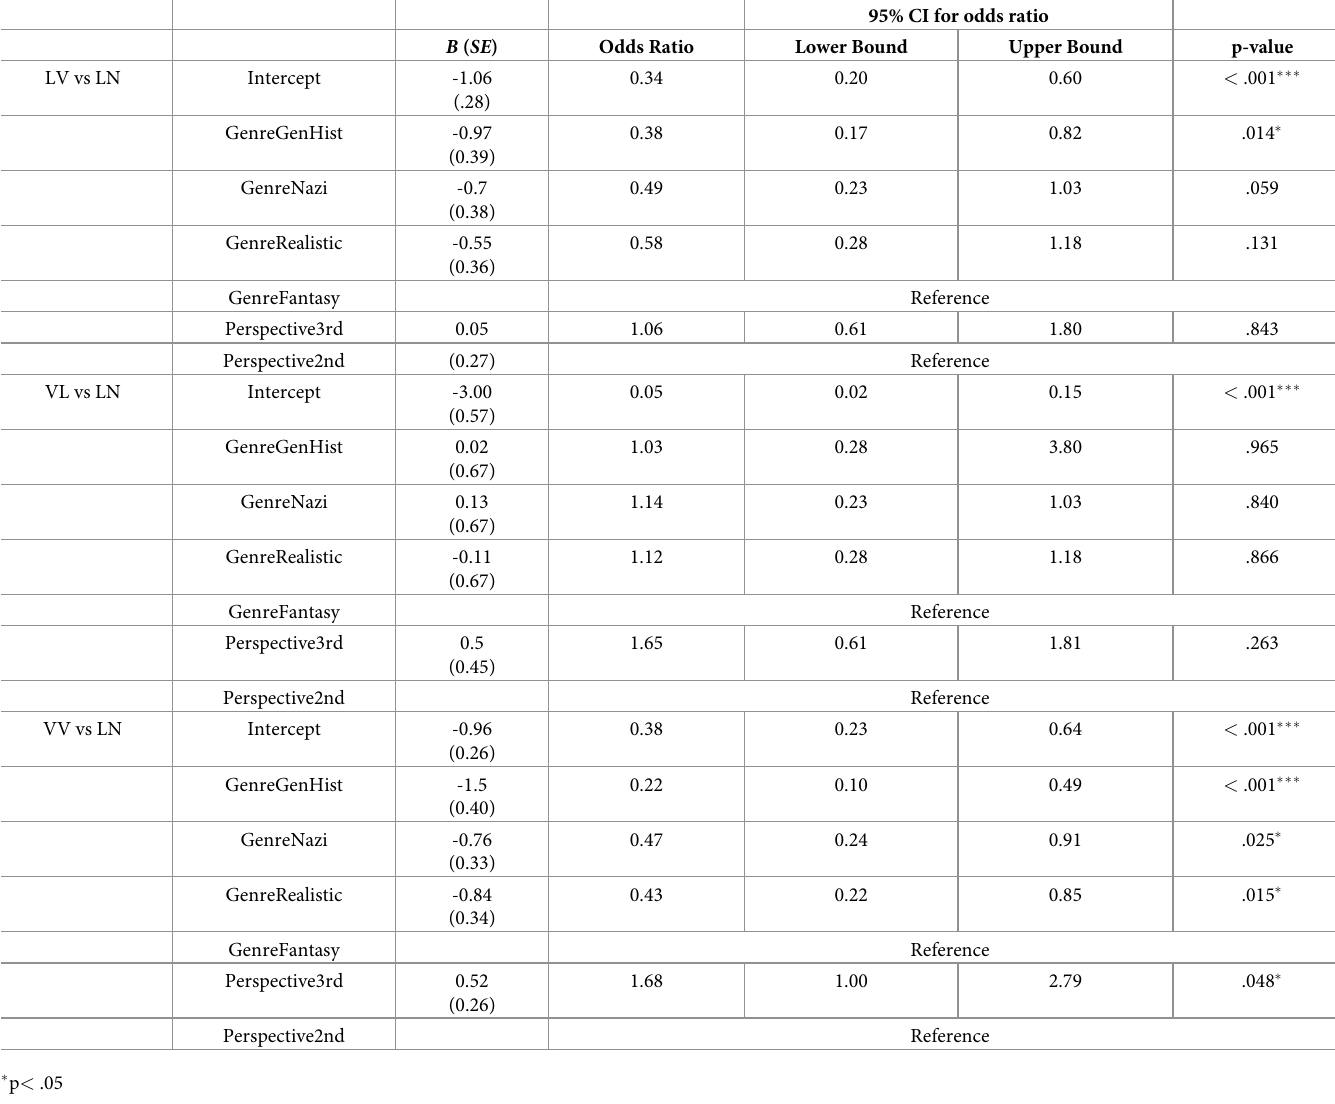
Table 7. Results of multinomial logistic regression: Effect of genre and perspective on story path (four